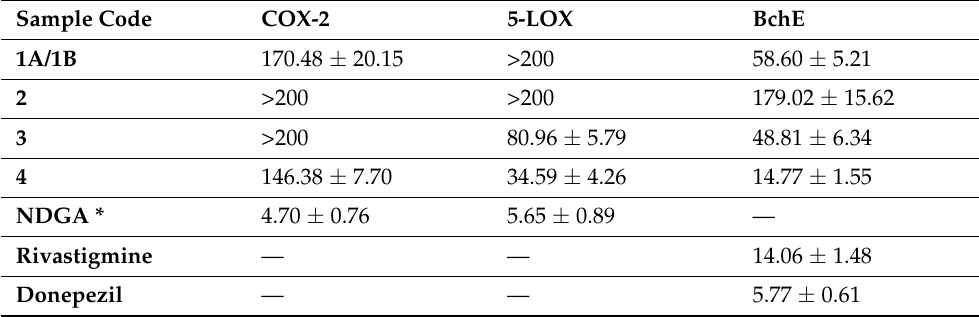
Table 3. IC 50 ( µ M) values of compounds 1A / 1B and 2 – 4 against COX-2, 5-LOX, and BchE enzymes in